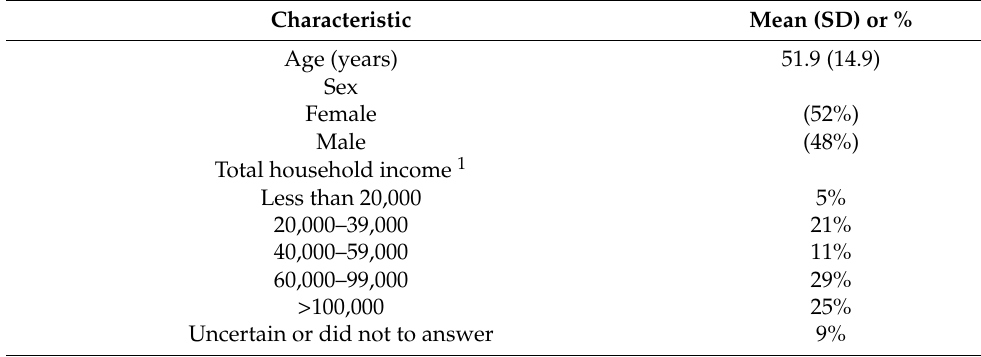
Table 1. Demographics and gambling profile of participants (N =